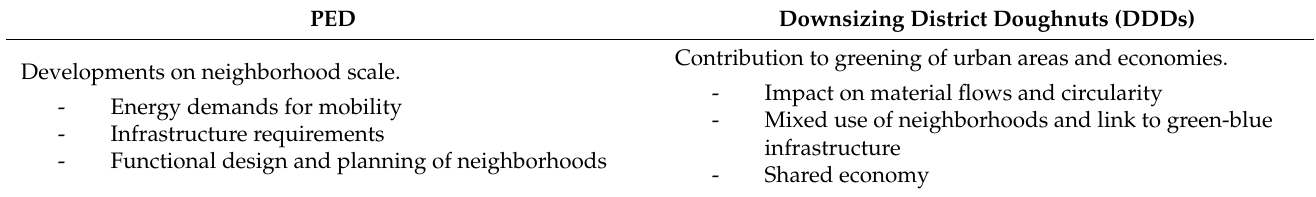
Table 4. Interface of the 15-Minute City with the other two Driving Urban Transition (DUT) pillars. PED